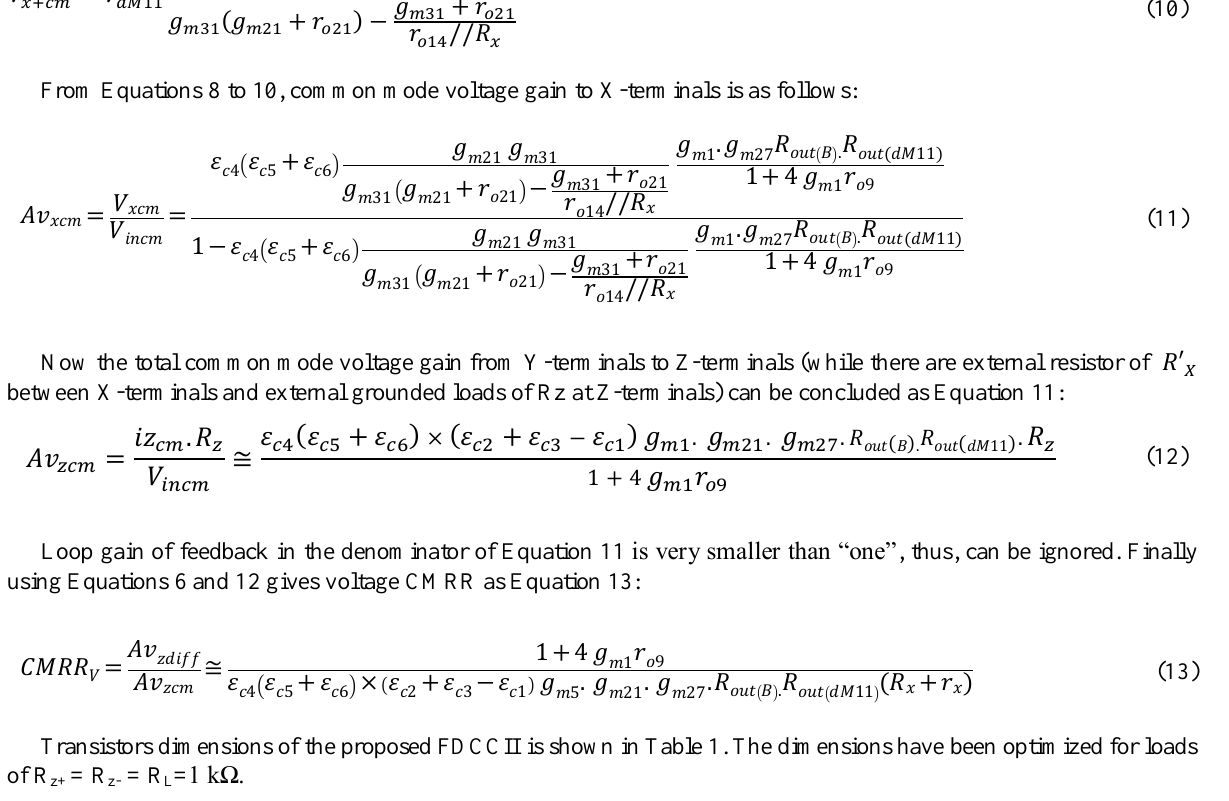
Table 1. Dimension of the transistors of the proposed